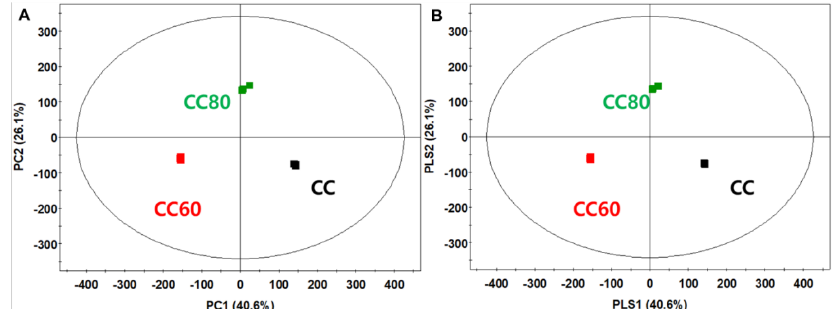
Figure 2. Multivariate statistical analysis of LC-MS datasets for fresh and heated CC juice extracts with dedicated conditions. ( A ) Principal component analysis (PCA) score plot. ( B ) Partial least squares discriminant analysis (PLS-DA) score plot. ■ CC, fresh CC juice; ■ CC60, CC juice heated at 60 °C for 8 h; and ■ CC80, CC juice heated at 80 °C for 3 h.